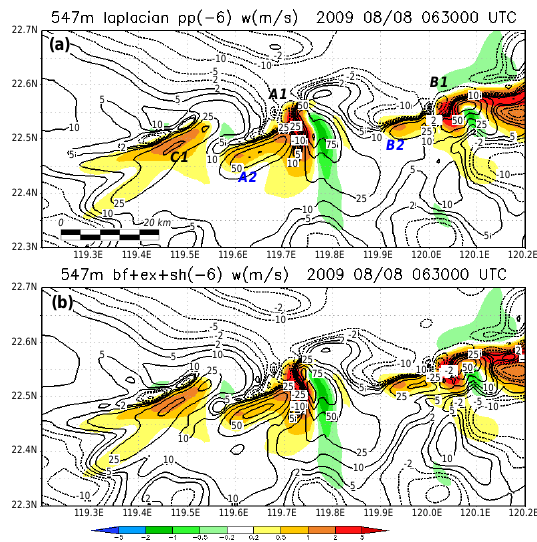
Figure 12. Model-simulated w (ms − 1 , color, scales at bottom) and (a) ∇ 2 p (cid:48) (10 − 6 Pam − 2 , contours, dashed for negative values) com- puted from p (cid:48) using the separation method and (b) ∇ 2 p (cid:48) obtained by adding all the right-hand-side terms in Eqs. (11) and (13) together, at 547m at 06:30UTC, 8 August 2009. Contour lev- els are at ± 2, ± 5, ± 10, ± 25, ± 50, ± 75, and ± 100 × 10 − 6 Pam − 2 , respectively, and are the same in (a, b) . The cells are labeled as in Fig.